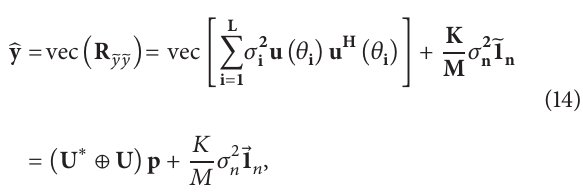
density function, 𝜇 is the mean of ̃ y , and R is its covariance